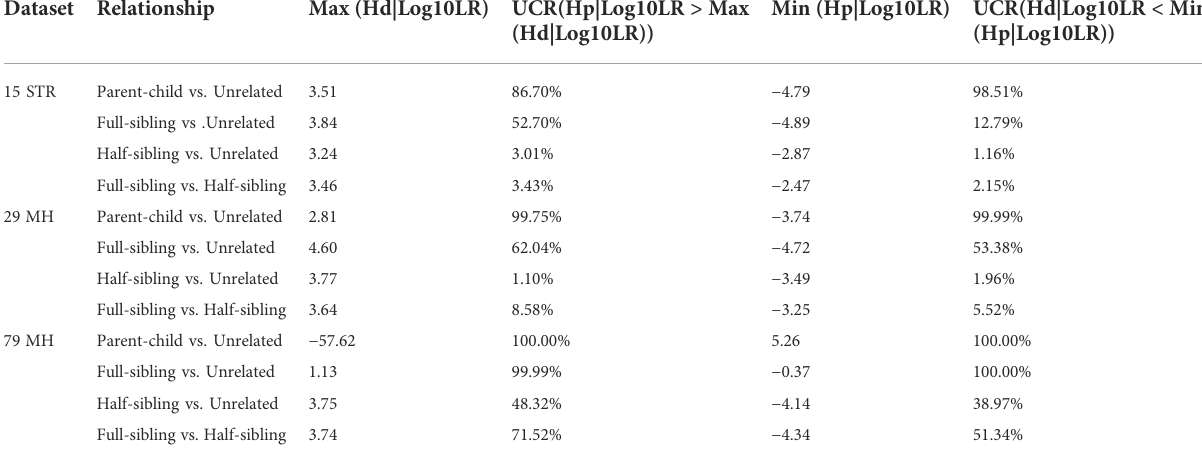
TABLE 3 The UCR values of four kinds of relationship pairs using the 15 STR loci, 29 microhaplotype loci and 79 microhaplotype loci. Dataset Relationship